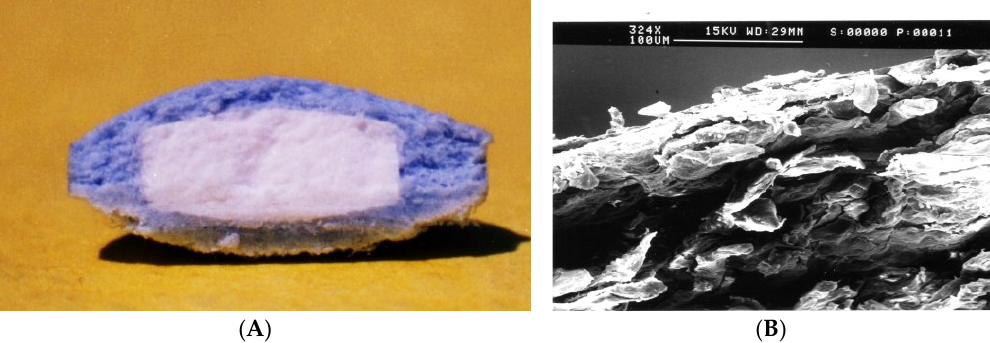
Figure 16. Cross-sectioned press-coated Chronotopic ® system ( A ) and SEM photomicrograph of the coating applied ( B ). Reprinted with permission from Ref. [58]. 2009, John Wiley & Sons.